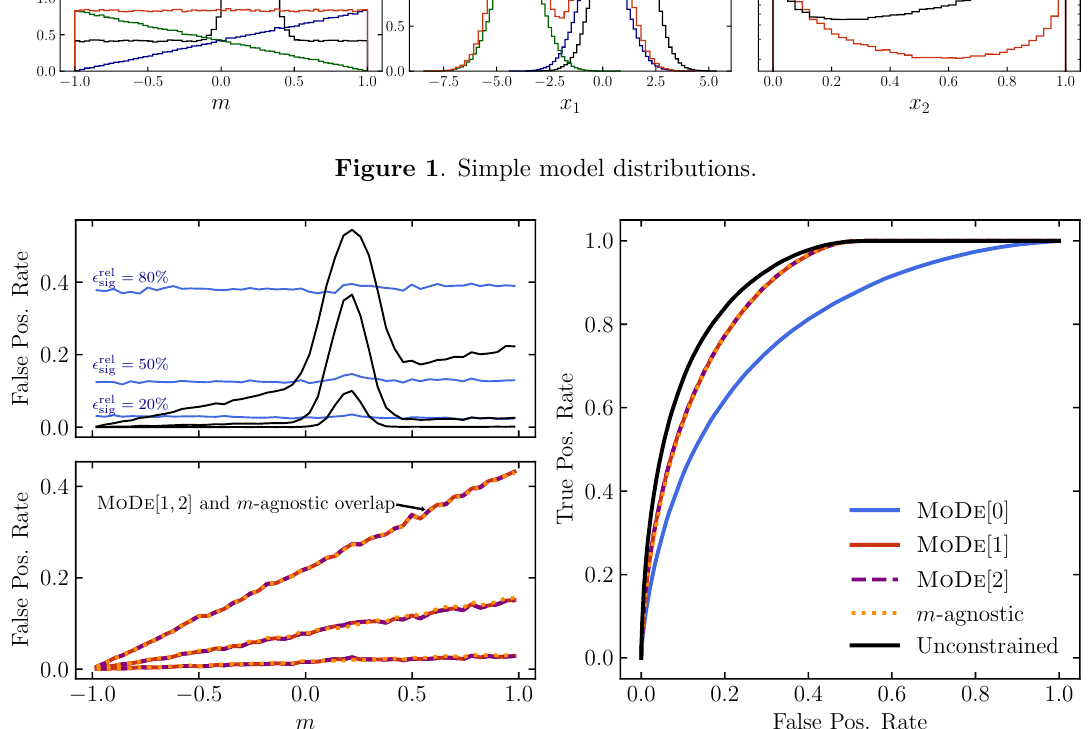
False Pos. = Figure 2 . Left: the false positive rate versus mass for various models at signal efficiencies (cid:15) rel sig 80 , 50 , 20% (each set of 3 identically colored and stylized lines correspond to the same model but with selection thresholds chosen to achieve the 3 desired signal efficiencies). The bottom panel shows that MoDe [1] and MoDe [2] completely overlap with the m -agnostic model for this simple example, which is expected because the optimal classifier here has linear dependence on mass (see text). Right: ROC curves for MoDe [0], MoDe [1], and MoDe [2] compared to the m -agnostic model and a model with unconstrained mass dependence. As in the left panel, we see that MoDe [1], MoDe [2], and the m -agnostic ROC curves are nearly identical because the optimal classifier has linear mass dependence in this simple